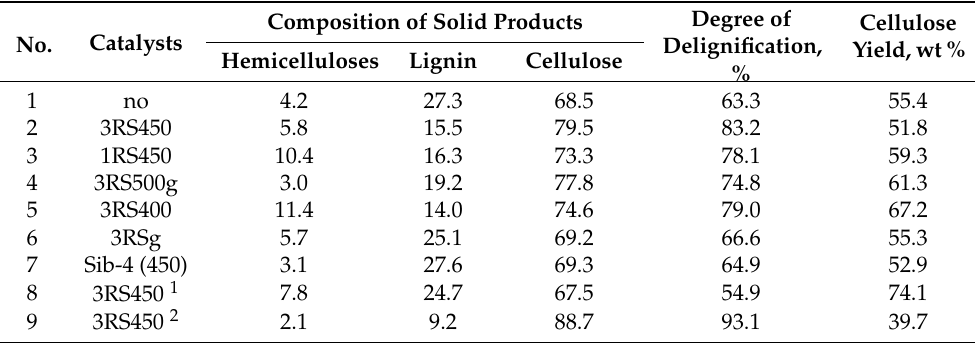
Table 6. Composition of the solid product, degree of delignification, and cellulose yield in noncatalytic and catalytic hydrogenation of flax shive in subcritical ethanol at 225 ◦